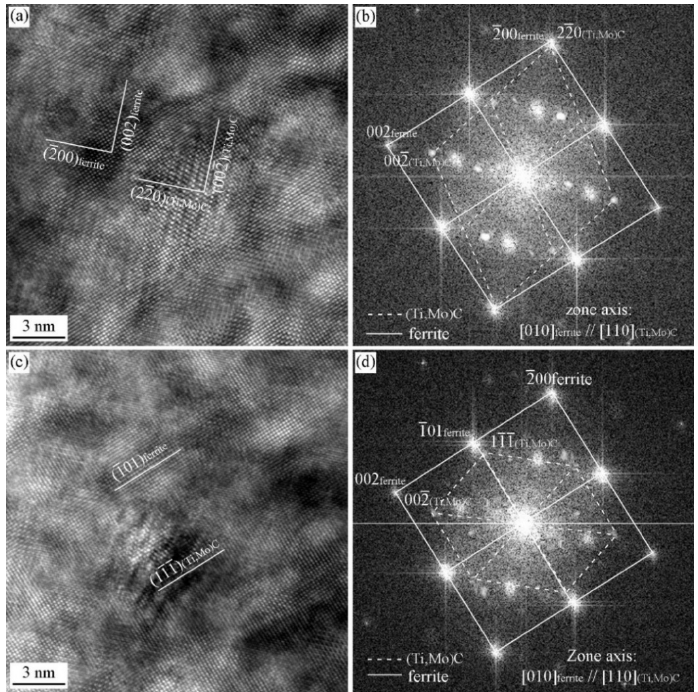
Figure 12. HRTEM image of precipitates and the ORs between the precipitates and ferrite matrix in the Ti-Mo steel produced by process II with the cooling rate of 20 °C/s ( a , c ) HRTEM image; ( b , d ) FFT diffractogram.